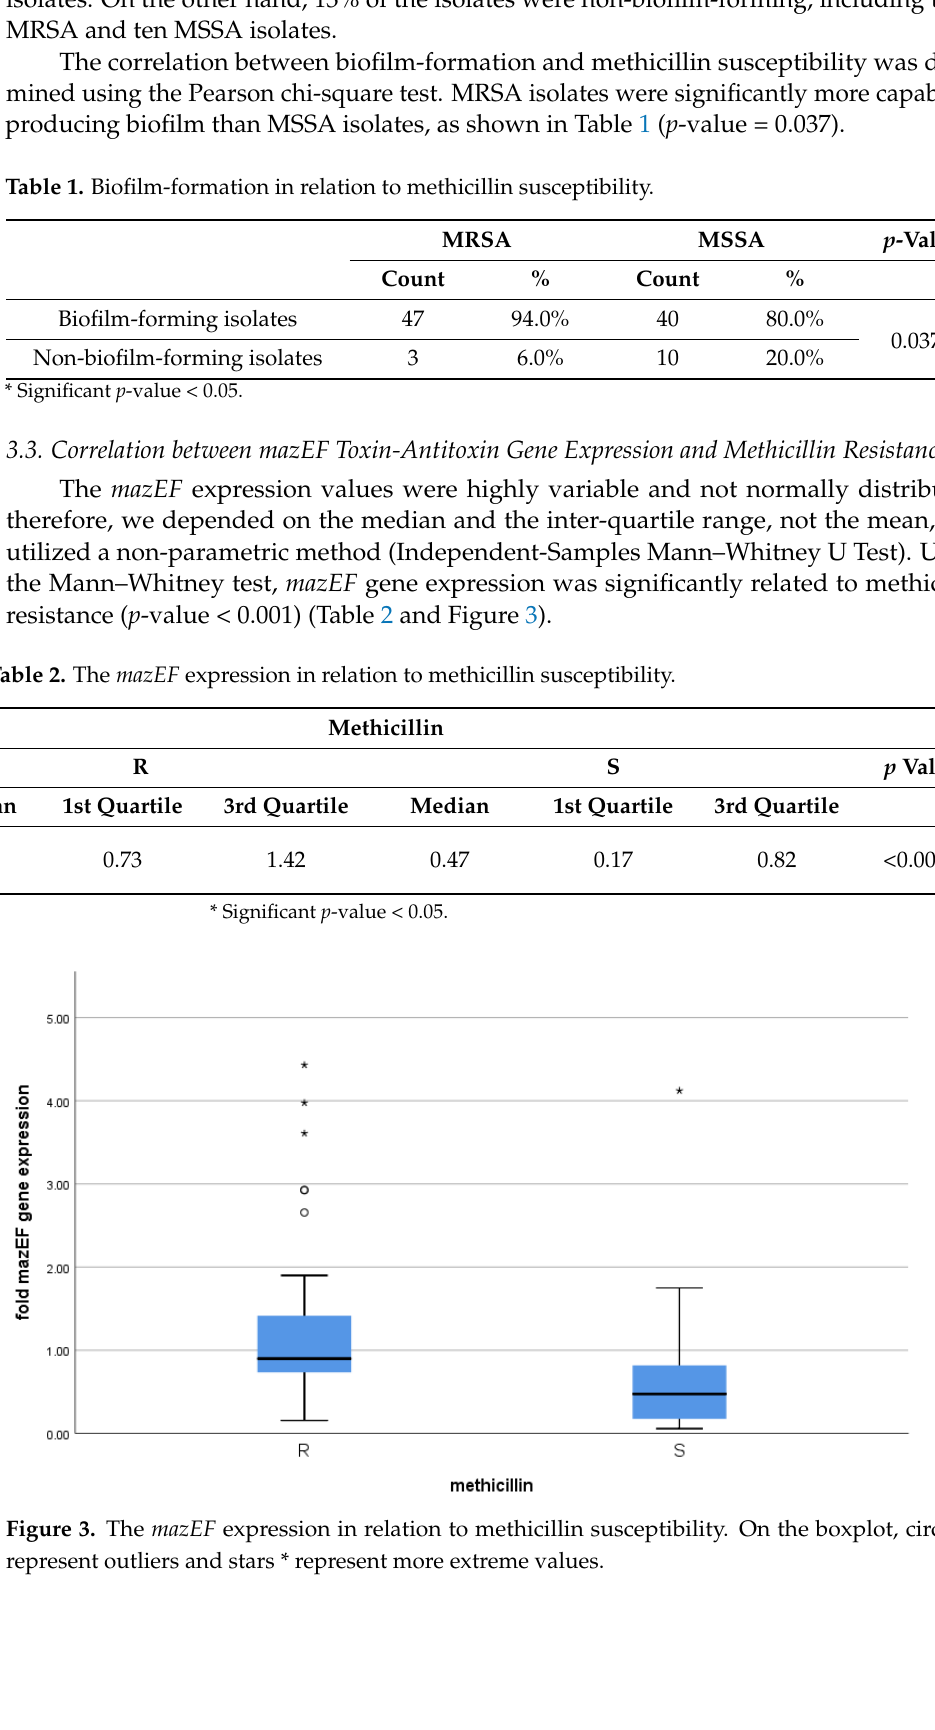
Table 3. The mazEF expression in relation to biofilm-formation. Biofilm Forming Yes 0.136 Figure 4. The mazEF expression in relation to biofilm-formation. On the boxplot, circles ° represent outliers and stars * represent more extreme values.